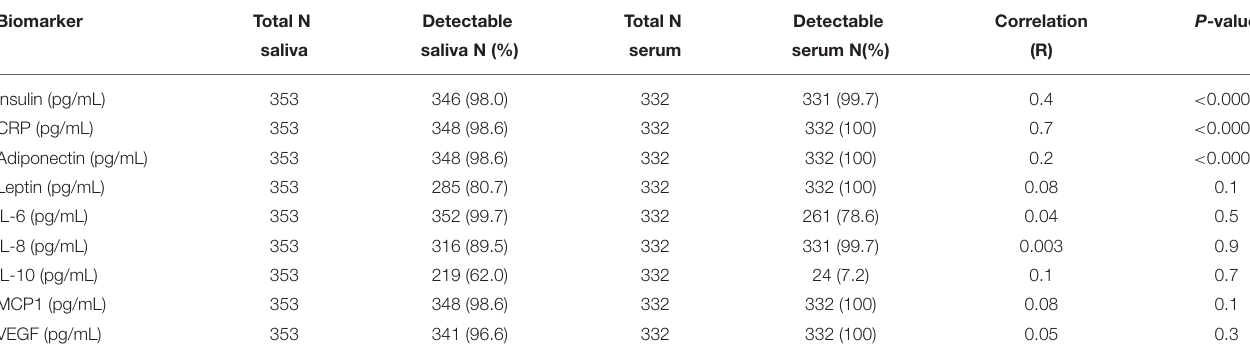
TABLE 4 | Pearson’s correlation coefficients between serum and salivary biomarker levels at visit 3.